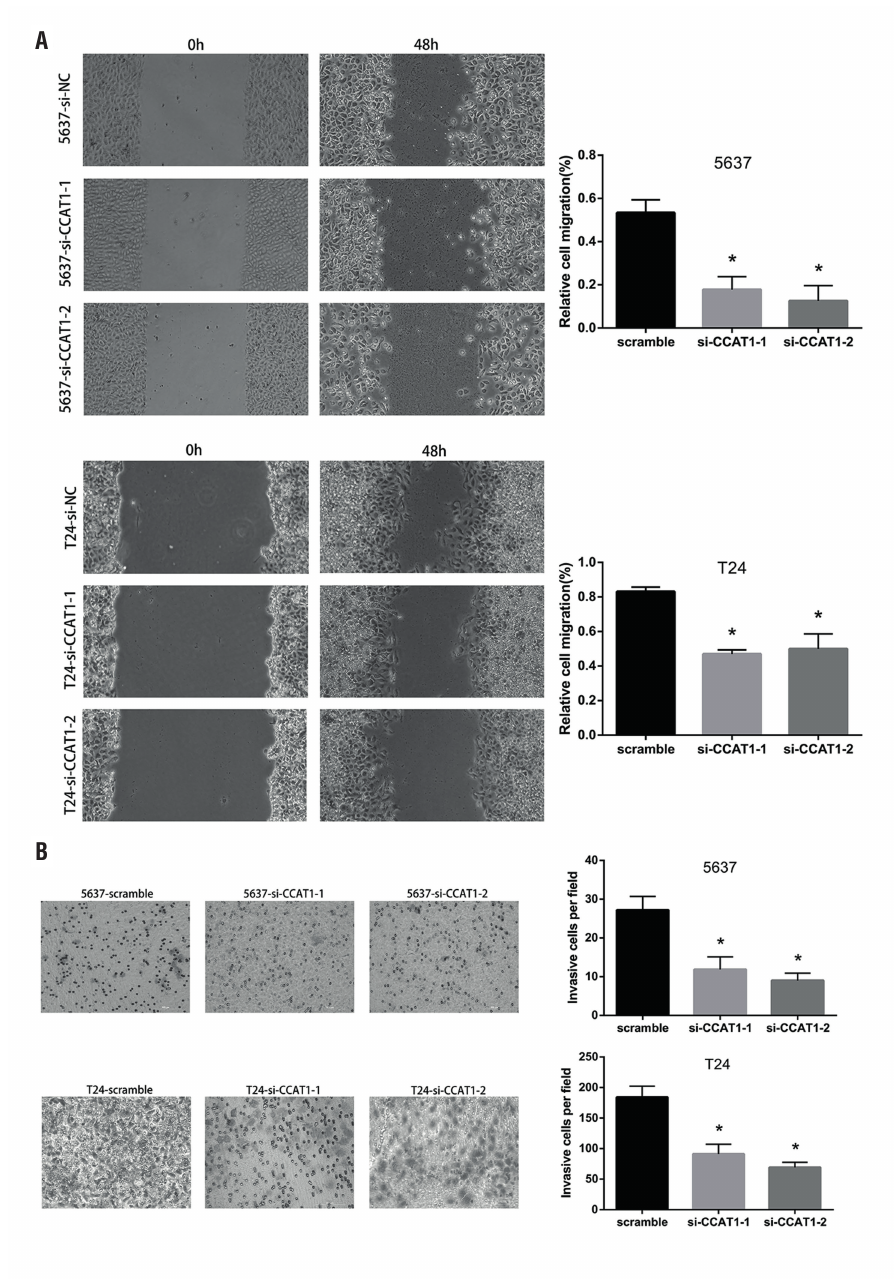
Figure 4 - Effects of CCAT1 on migration and invasion capability in 5637 and T24 cells. A) Knock-down of CCAT1 attenuated the migration ability of 5637 and T24 cells. The quantifications of cell migration were presented by the histogram. B) Trans- well assay indicated that knock-down of CCAT1 weakened 5637 and T24 cells invasion. The quantifications of cell invasion were presented by the column